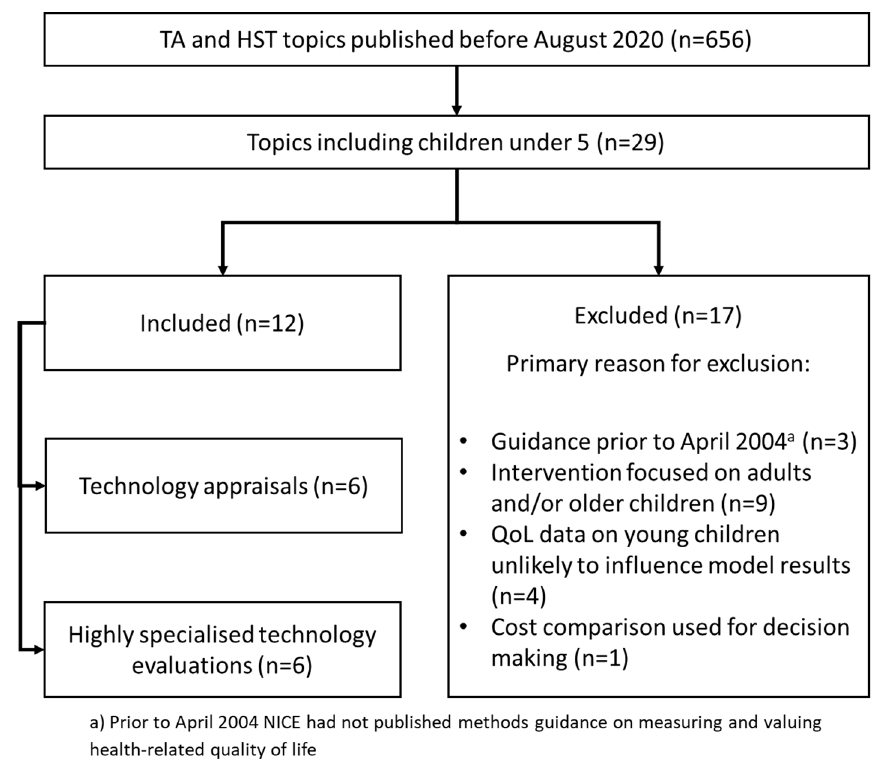
Figure 1. Number of topics in analysis set and primary reasons for exclusion.